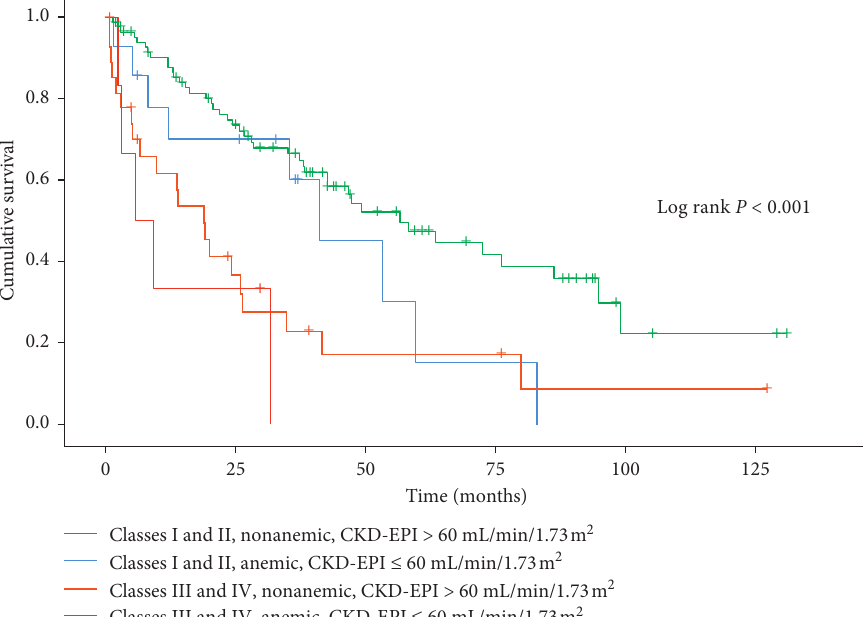
Figure 1: Survival probabilities of patients with Chagas cardiomyopathy according to chronic kidney disease and anemia status associated with New York Heart Association Functional